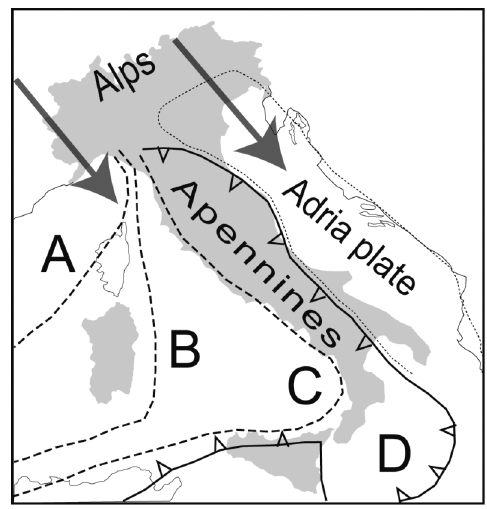
Fig. 1. Sketch of the geodynamic evolution of the Italian region. Dashed lines indicate the approximate position of the Apennines front - and coeval opening of the Tyrrhenian Sea - at A (20 Ma), B (10 Ma), C (1 Ma) and the actual position (D) according to the paleotectonic reconstruction by Faccenna et al. (2001). Line D has a hatches pattern with the direc- tion corresponding to the subduction dip and repre- sents the present-day location of the convergent boundary. The dotted line indicates the boundary of the Adria plate. Large arrows indicate the present- day convergence direction between the Africa and Eurasia plates (DeMets et al. ,